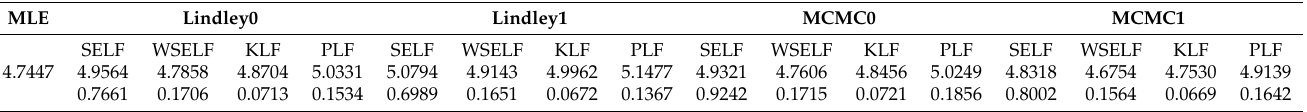
Table 7. Bayesian estimates and corresponding PRs (second row) of entropy for different loss functions. For hyperparameters, a = 1, b = 1, c = 2, d = 1.